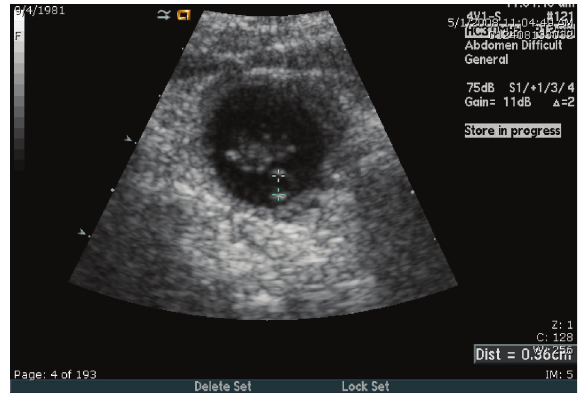
Figure 2: Initial ultrasound image of infrahepatic region of the abdominal wall noting a gestational sac with yolk sac and fetal